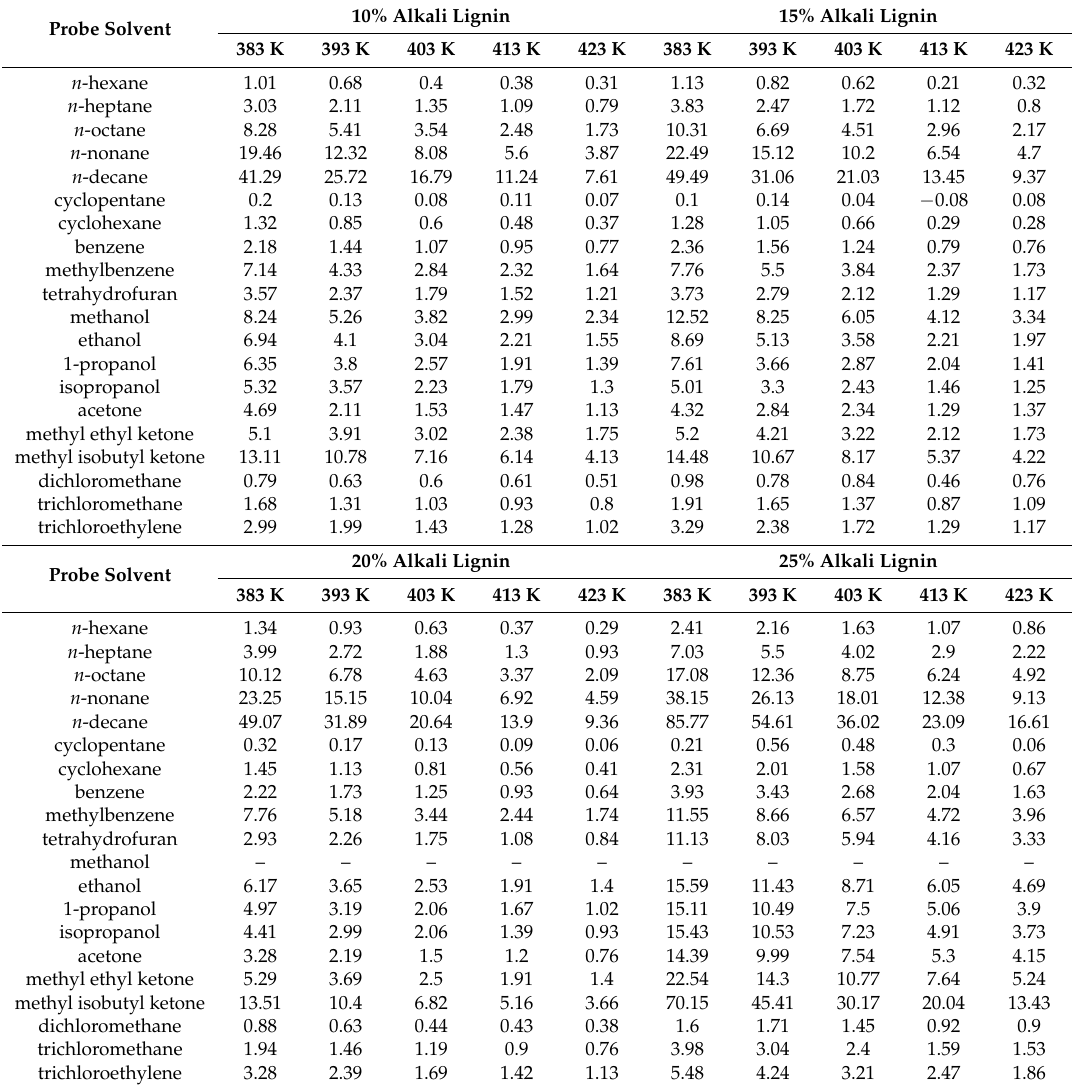
Table A1. Specific retention volumes ( V 0 g ) at different temperatures (mL · g − 1